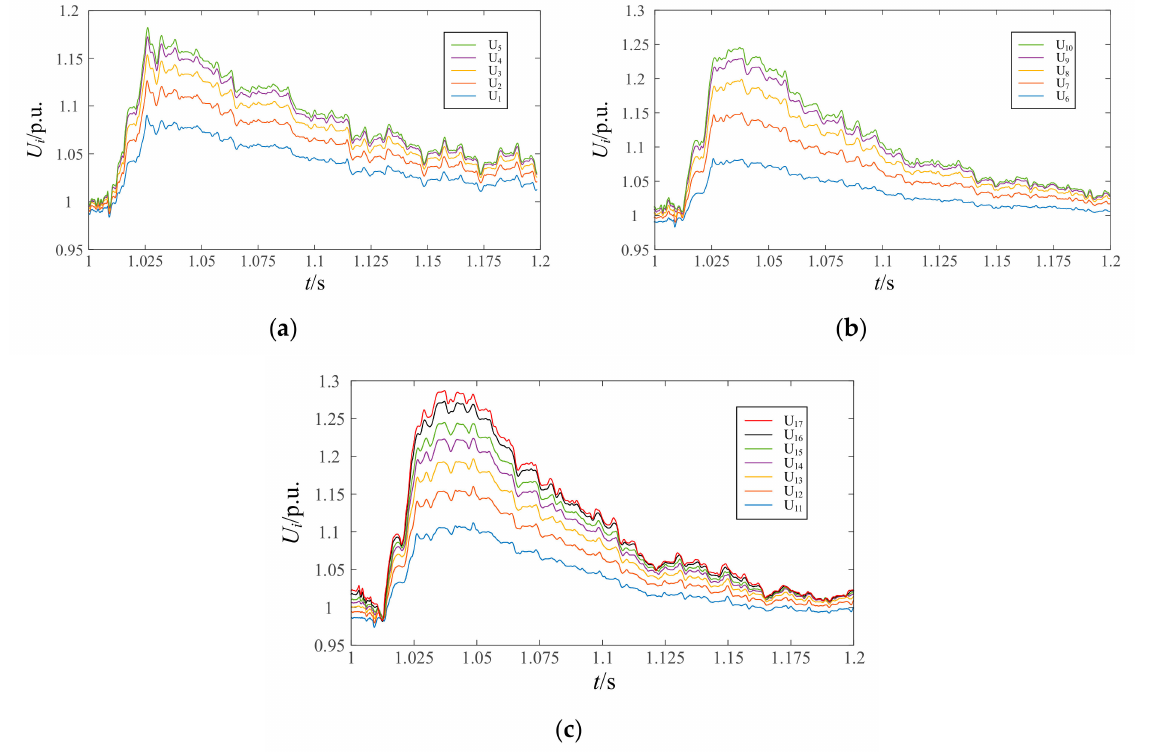
Figure 15. The partial of generator terminal voltage variation curve, considering the grid-connection node as the control target. ( a ) Line 1. ( b ) Line 2. ( c ) Line